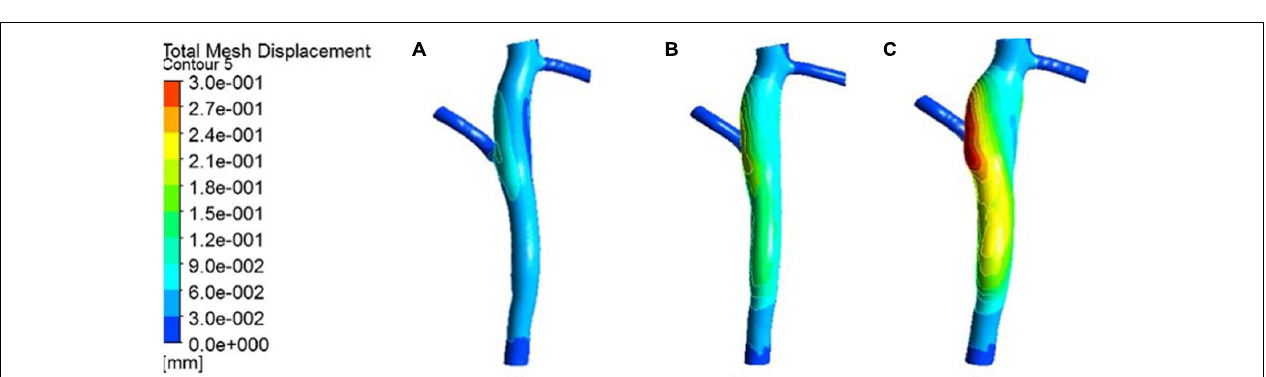
FIGURE 6 | Deformation contour of the LAD in maximum time. (A) normal condition; (B) the Young’s modulus of the atherosclerotic site is 0.27MPa; (C) the Young’s modulus of the atherosclerotic site is 0.027 MPa.